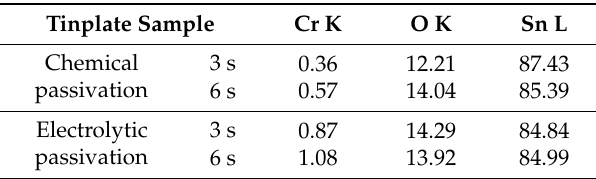
Figure 11. Energy Dispersive X-ray Spectroscopy (EDX) survey spectrogram of the tinplate surface treated with ( a , b ) chemical passivation for 3 s and 6 s, respectively, and ( c , d ) electrolytic passivation for 3 s and 6 s, respectively. Table 3. Atomic percentage (at.%) of the elements on the tinplate surface treated with different passivation processes.